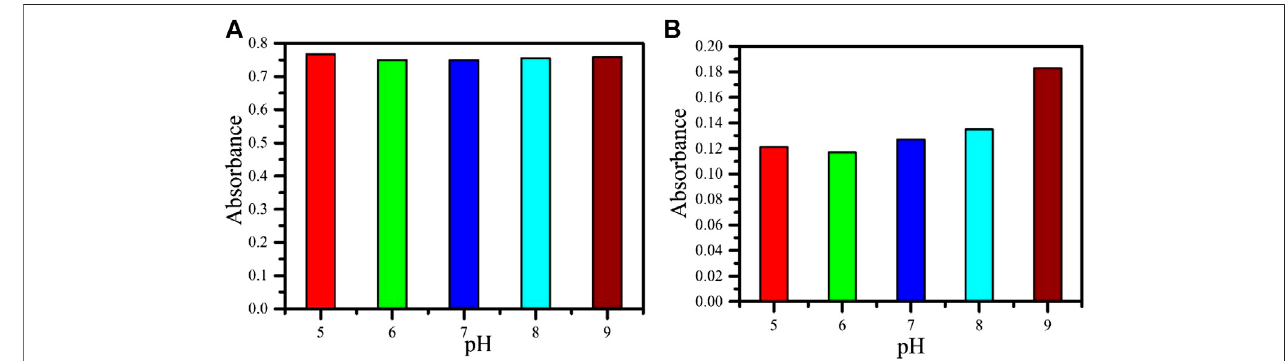
FIGURE 4 | (A) The effect of different pH for AFB1. (B) The effect of different pH for OchA.